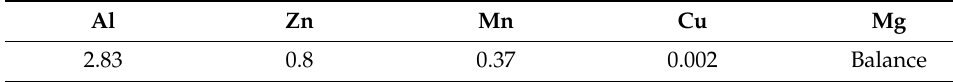
Table 1. Chemical composition of magnesium alloy AZ31 (wt%).